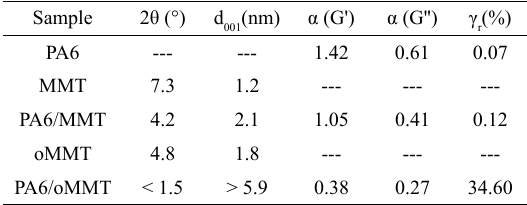
Table 2. Parameters obtained from WAXD (θ = diffraction angle, d for the extruded